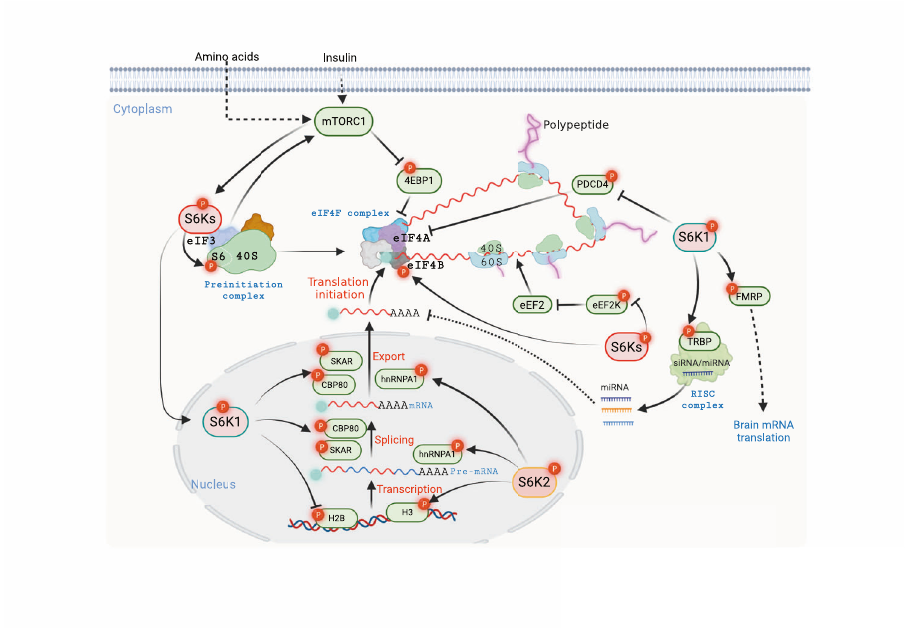
Fig. 4 S6K controls cell size by directing multiple processes of protein synthesis. Phosphorylation of histones by S6K may dictate speci fi c gene transcription, followed by phosphorylation and activation of CBC and EJC components, which play key roles in pre-mRNA maturity and exportation. S6Ks also function in preinitiation complex formation and translation initiation by phosphorylating eIF3, S6, eIF4B, and PDCD4, resulting in ef fi cient initiation of protein synthesis. On the other hand, during elongation, phosphorylation of eEF2K by S6Ks favors an active state of eEF2, resulting in ef fi cient ribosome translocation and protein